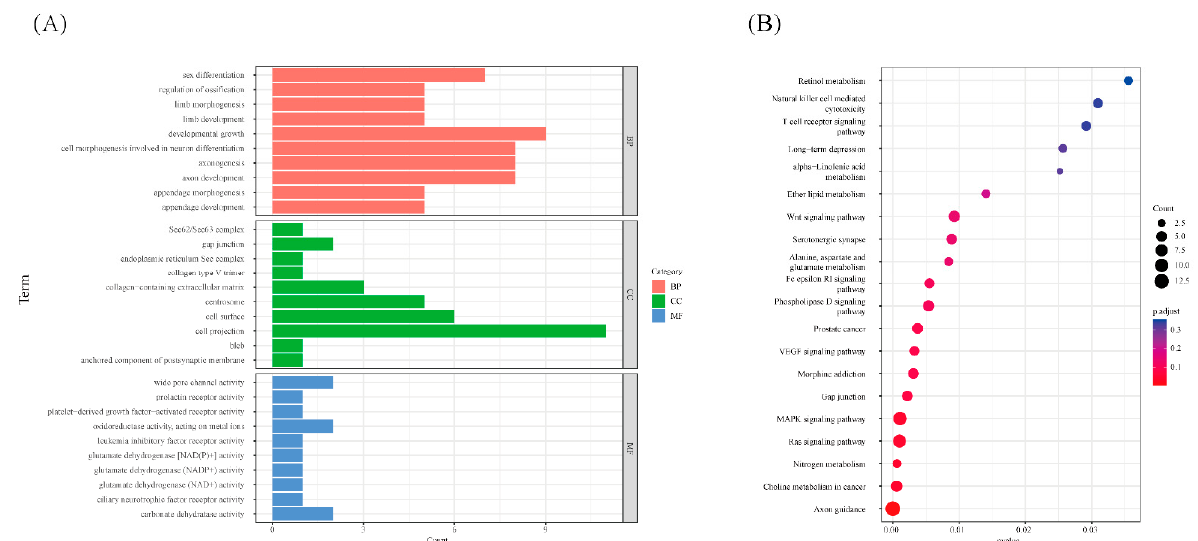
Figure 4. The function analysis of the selected genes, ( A ) GO analysis of the selected genes, red referring to biological process, green referring to cellular component and blue referring to molecular function. ( B ) KEGG analysis of the selected genes, the size of dot refers to the number genes related to pathway, and the red to blue indicate the significant p -value change.